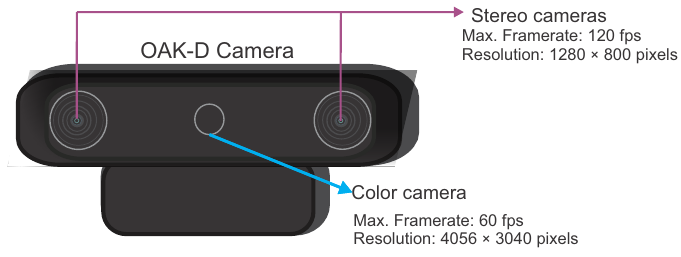
Figure 1. OAK-D Camera.